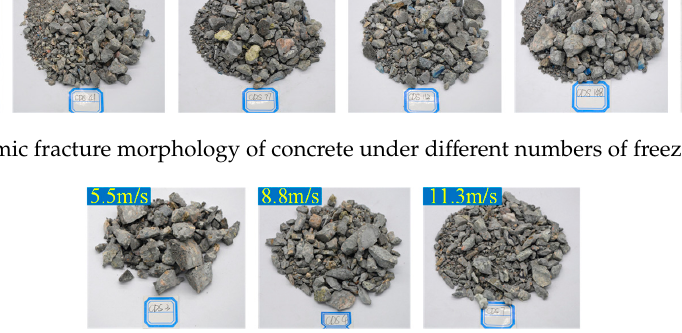
Figure 4. Dynamic fracture morphology of concrete under different impact velocities.